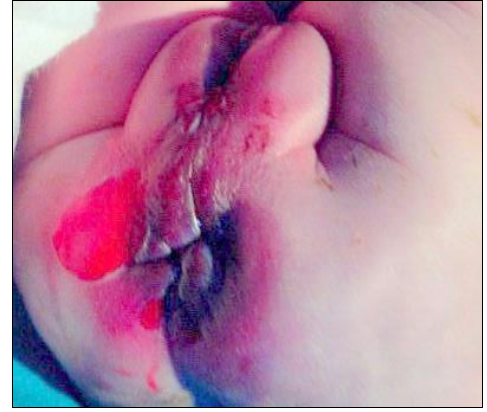
Figure 1: Hematoma over right buttock 4x4cm with abrasion of overlying skin, anal laceration of 0.5 x 1cm, and perianal edema.